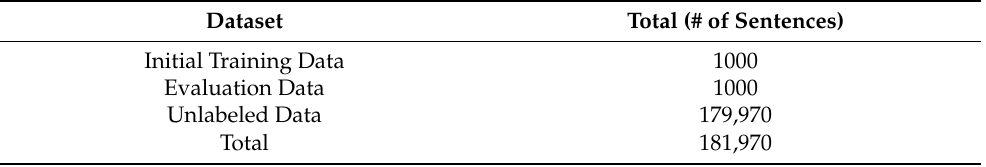
Table 2. The organization of the initial dataset. Initial training data and evaluation data are manu- ally